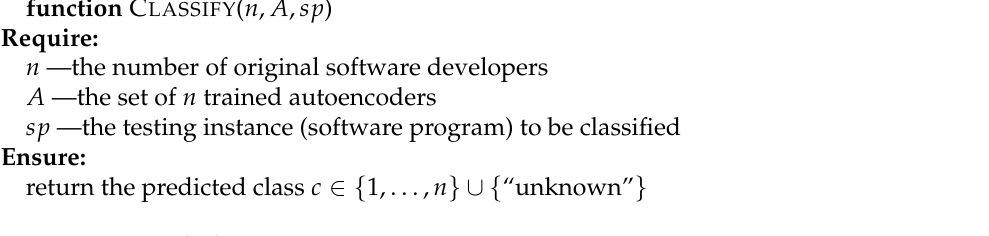
Algorithm 1 Classification for the testing instance sp , considering an additional “unknown”